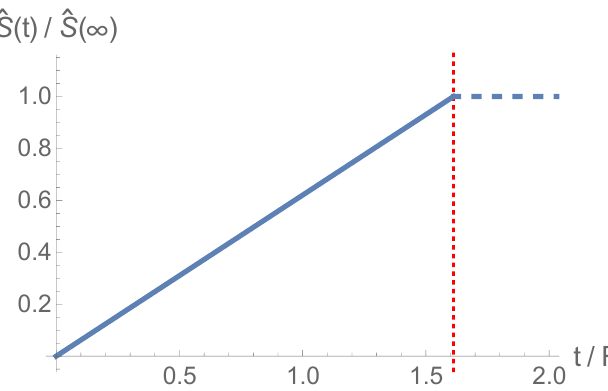
Figure 3. Entropy growth for a strip of width 2 R from a d = 4 Schwarzschild black hole in the limit of large region sizes. The above rescaled curve is exactly linear with slope v E , which gives a saturation time t S = R . This saturation time satis(cid:12)es the bound (1.12), if we use that v E v E v B (cid:20)